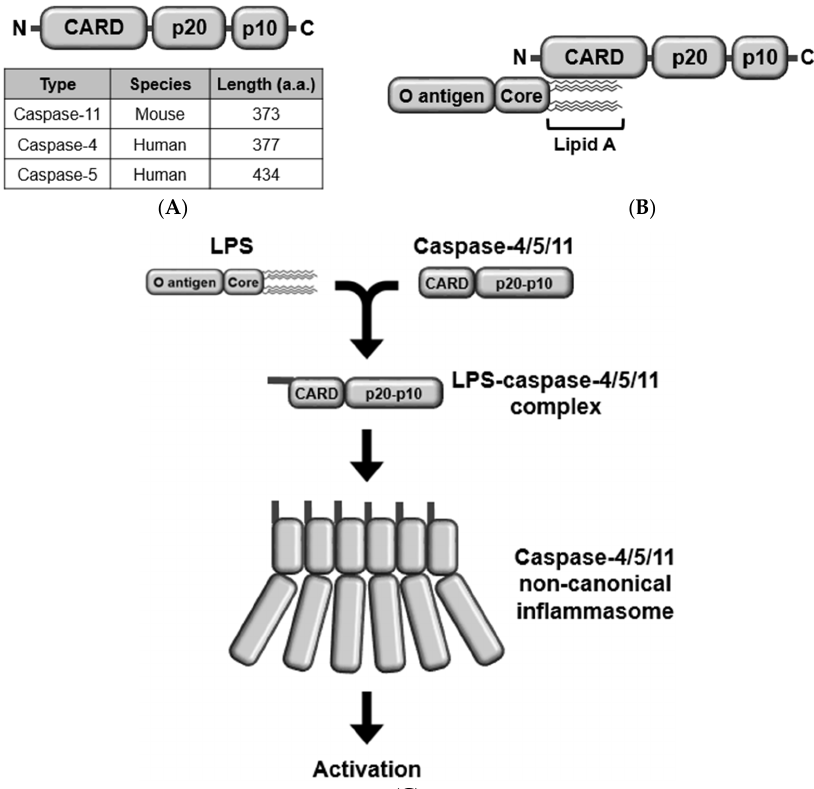
Figure 1. Structure and activation of caspase-11 non-canonical inflammasome. ( A ) Structures of mouse caspase-11 and human caspase-4 and -5. The three non-canonical inflammasomes have the same domain structures consisting of an N-terminal CARD, a p20, and C-terminal p10, but different sizes as indicated. ( B ) LPS directly interacts with mouse caspase-11 or human caspase-4/5 through a lipid A moiety of LPS and a CARD of caspase-11. ( C ) Activation of caspase-11 non-canonical inflammasome by oligomerizing LPS-caspase-4/5/11 complexes. CARD, caspase recruit domain; LPS, lipopolysaccharide.